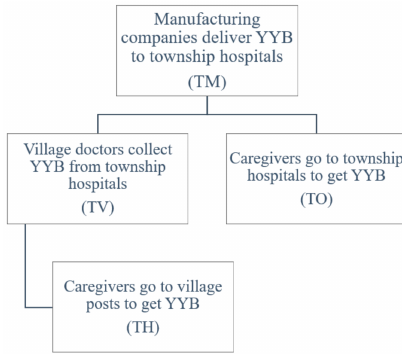
Figure 1. The types of delivery and associated costs for YYB, from manufacturing companies to eligible